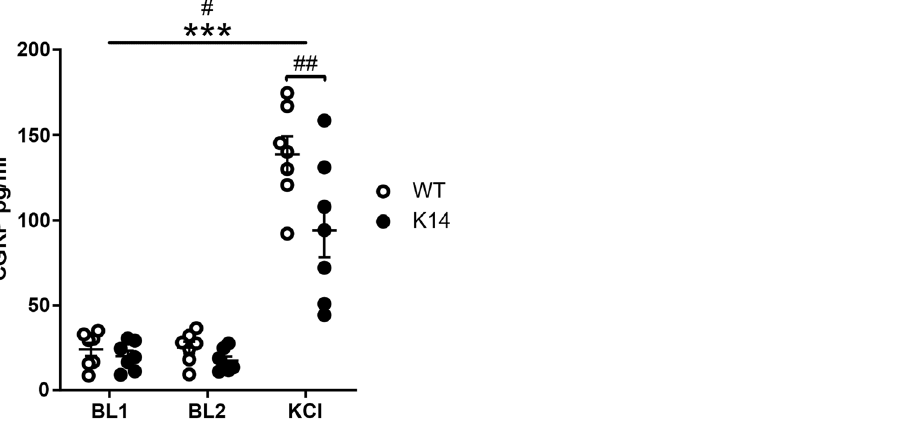
Figure 4. CGRP released from the meningeal trigeminal nerve endings in the hemiskull preparation. CGRP release was not altered in K14 hemiskulls under basal conditions. The application of 30 mM KCl triggered a significant increase in the CGRP level in both genotypes, and overall CGRP release was higher in WT animals. Post-hoc comparisons revealed that the concentration of the released CGRP under the stimulation was significantly lower in the hemiskulls lacking the lymphatic system compared to the WT preparations. ( B ) We propose two possible explanations for the altered CGRP release: (1) lower density of trigeminal afferents releasing CGRP, or (2) lower expression of CGRP. *** p < 0.001 (treatment effect); # p = 0.03 (genotype effect); ## p = 0.002 (KCl-WT vs. KCl-K14) by matched two-way ANOVA with Bonferroni post-hoc